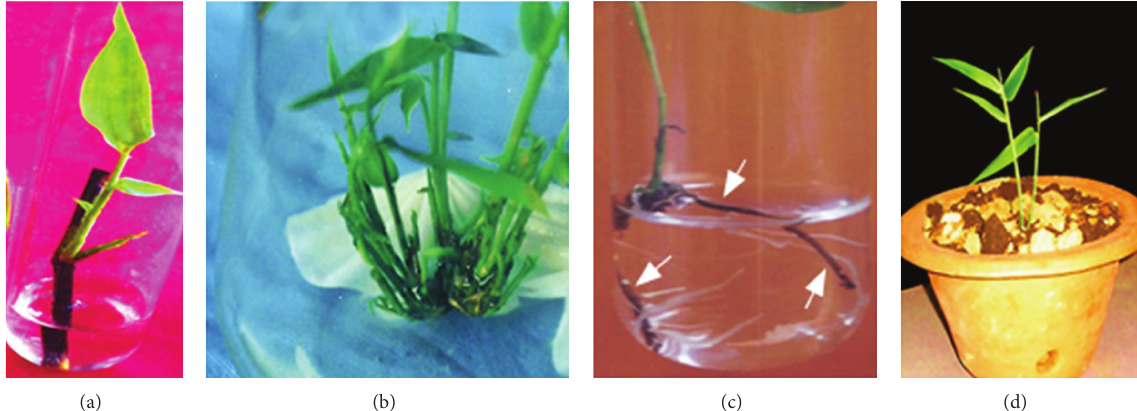
Figure 3: Micropropagation of Bambusa tulda . (a) Node with axillary bud breaks in liquid MS medium. (b) Shoot multiplication in 2 mg/L Kn + 3 mg/L BAP. (c) Formed rhizome (tagged with arrows) produced multiple profuse whitish roots in 0.5 MS medium supplemented with